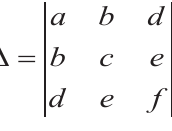
and the boundary in moment space 0